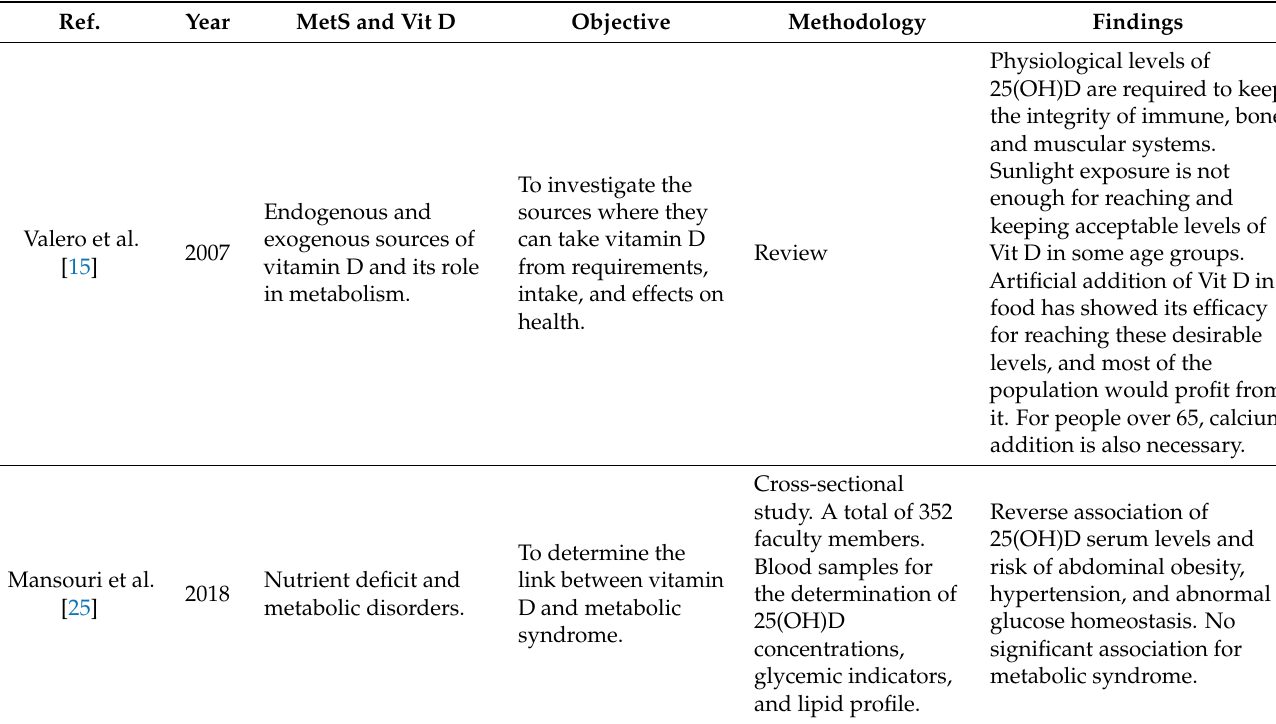
Table 1. Key findings of reviewed